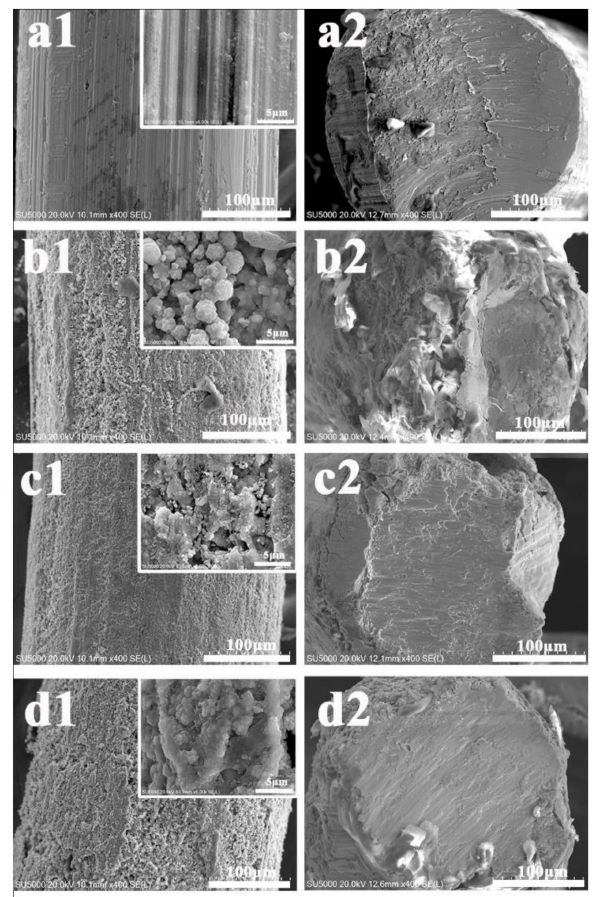
Figure 1. SEM for the pristine wire ( a1 , a2 ), the superhydrophilic wire ( b1 , b2 ), the superhydrophobic wire ( c1 , c2 ), and the UV-irradiated superhydrophilic wire ( d1 , d2